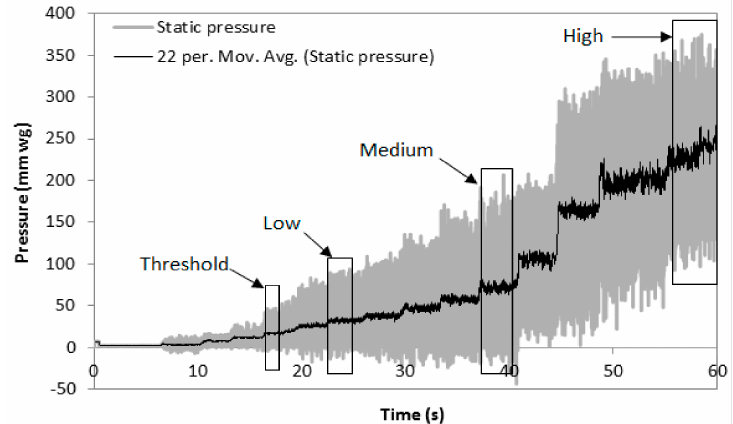
Figure 5. The four pressure categories used to compare the three waterless trap seals.